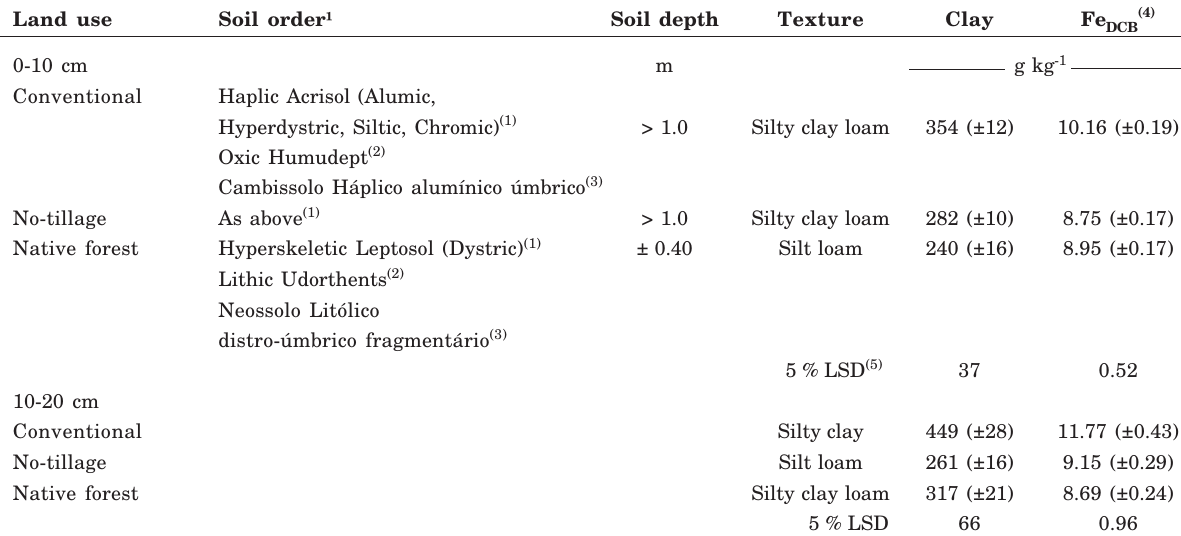
(1) IUSS-WRB (2006), (2) Soil Survey Staff (2010), (3) Santos et al. (2006); (4) Fe significant difference at 5 % (error degrees of freedom =